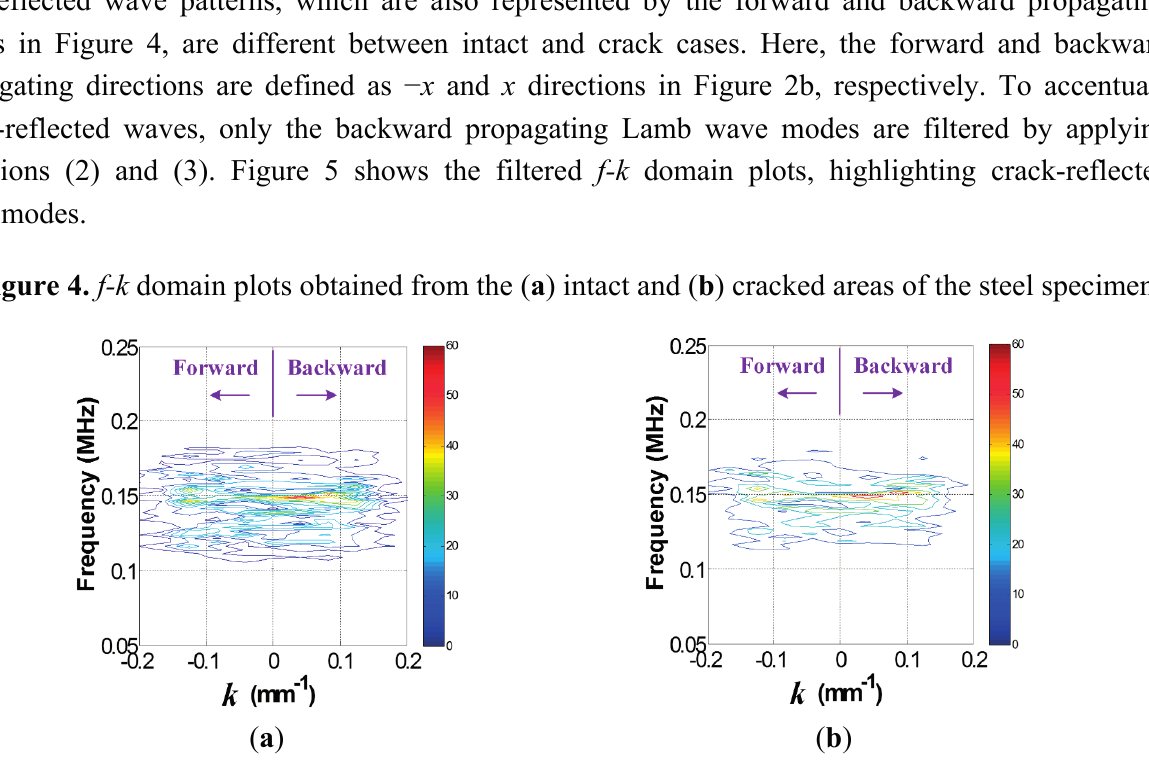
Figure 5. Filtered f-k domain plots obtained from the ( a ) intact and ( b ) cracked areas of the steel